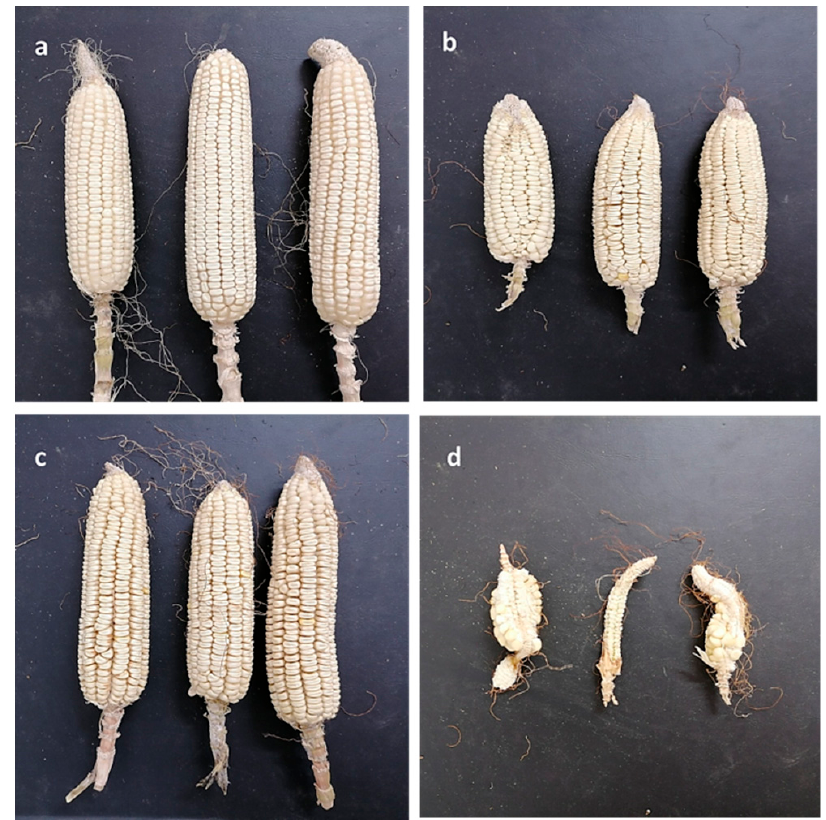
Figure 8. Effect of different treatments, ( a ) nano-chitosan 5 mM, ( b ) chitosan 5 mM, ( c ) fungicide Premis Ultra 2.5%, and ( d ) disease control, on ear size and shape of Giza 166 cv. Table 2. Effect of chitosan, nano-chitosan, and Premis Ultra 2.5% fungicide on disease severity and crop parameters of some corn cultivars under natural infection with late wilt disease.